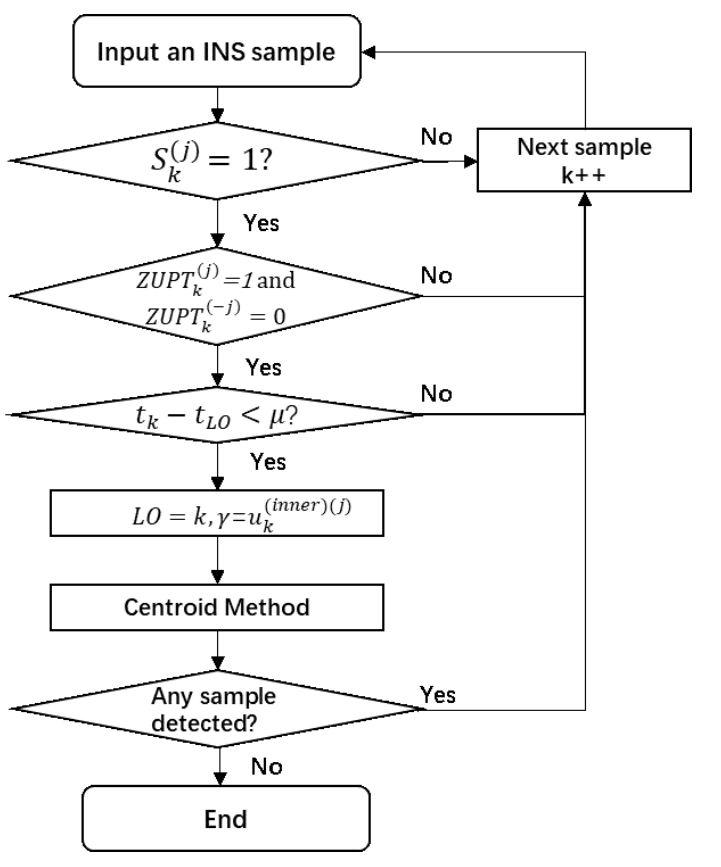
Figure 3. Process of MCD